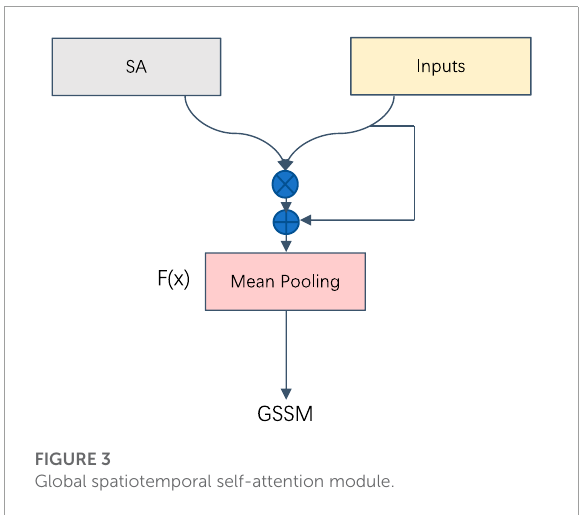
FIGURE 3 Global spatiotemporal self-attention module.